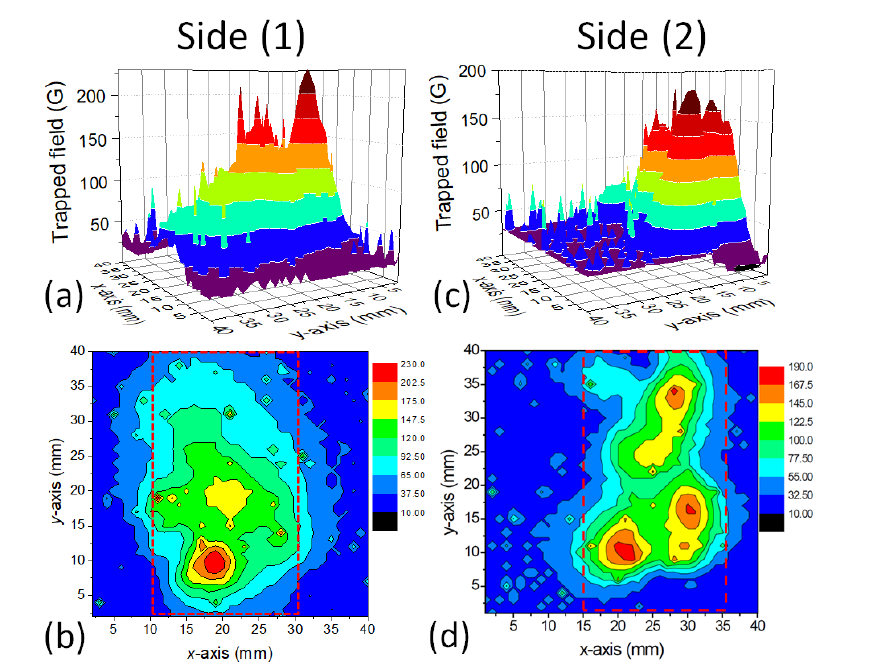
Figure 3. Trapped field measurements on a foam sample. Distribution of B z measured by scanning Hall probe on different sample sides of the foam as surface plots ( a , c ) and contour plots ( b , d ). ( a , b ) present the data of sample Side (1), ( c , d ) sample Side (2). The sample position is marked in the contour plots by a dotted red line. The permanent magnet in the FC cooling process was placed on each side in a separate measurement run.